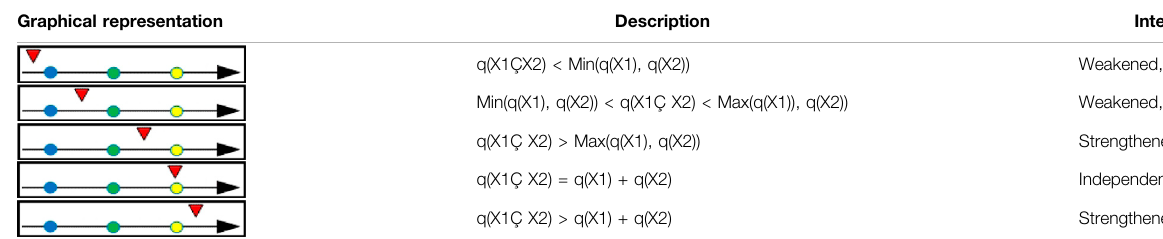
TABLE 1 | Detection of interaction.